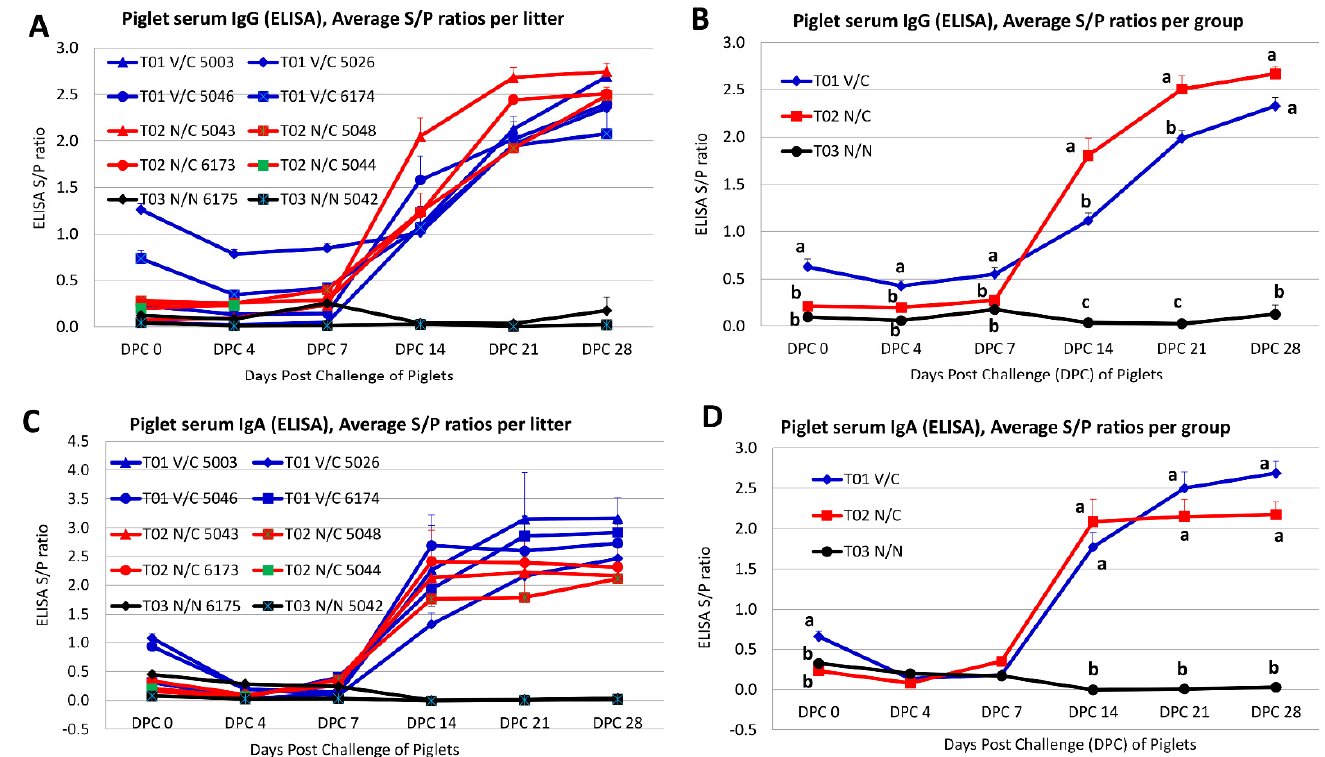
Figure 4. The S/P ratios of PEDV antibody in piglet sera as tested by a PEDV whole virus-based ELISA. ( A ) The average S/P ratios of piglet serum IgG per litter. ( B ) The average S/P ratios of piglet serum IgG per group. ( C ) The average S/P ratios of piglet serum IgA per litter. ( D ) The average S/P ratios of piglet serum IgA per group. Error bars indicate standard error. Different letters indicate significant differences. The positive cutoff for serum IgG and IgA was an S/P ratio equal to or greater than 0.7.